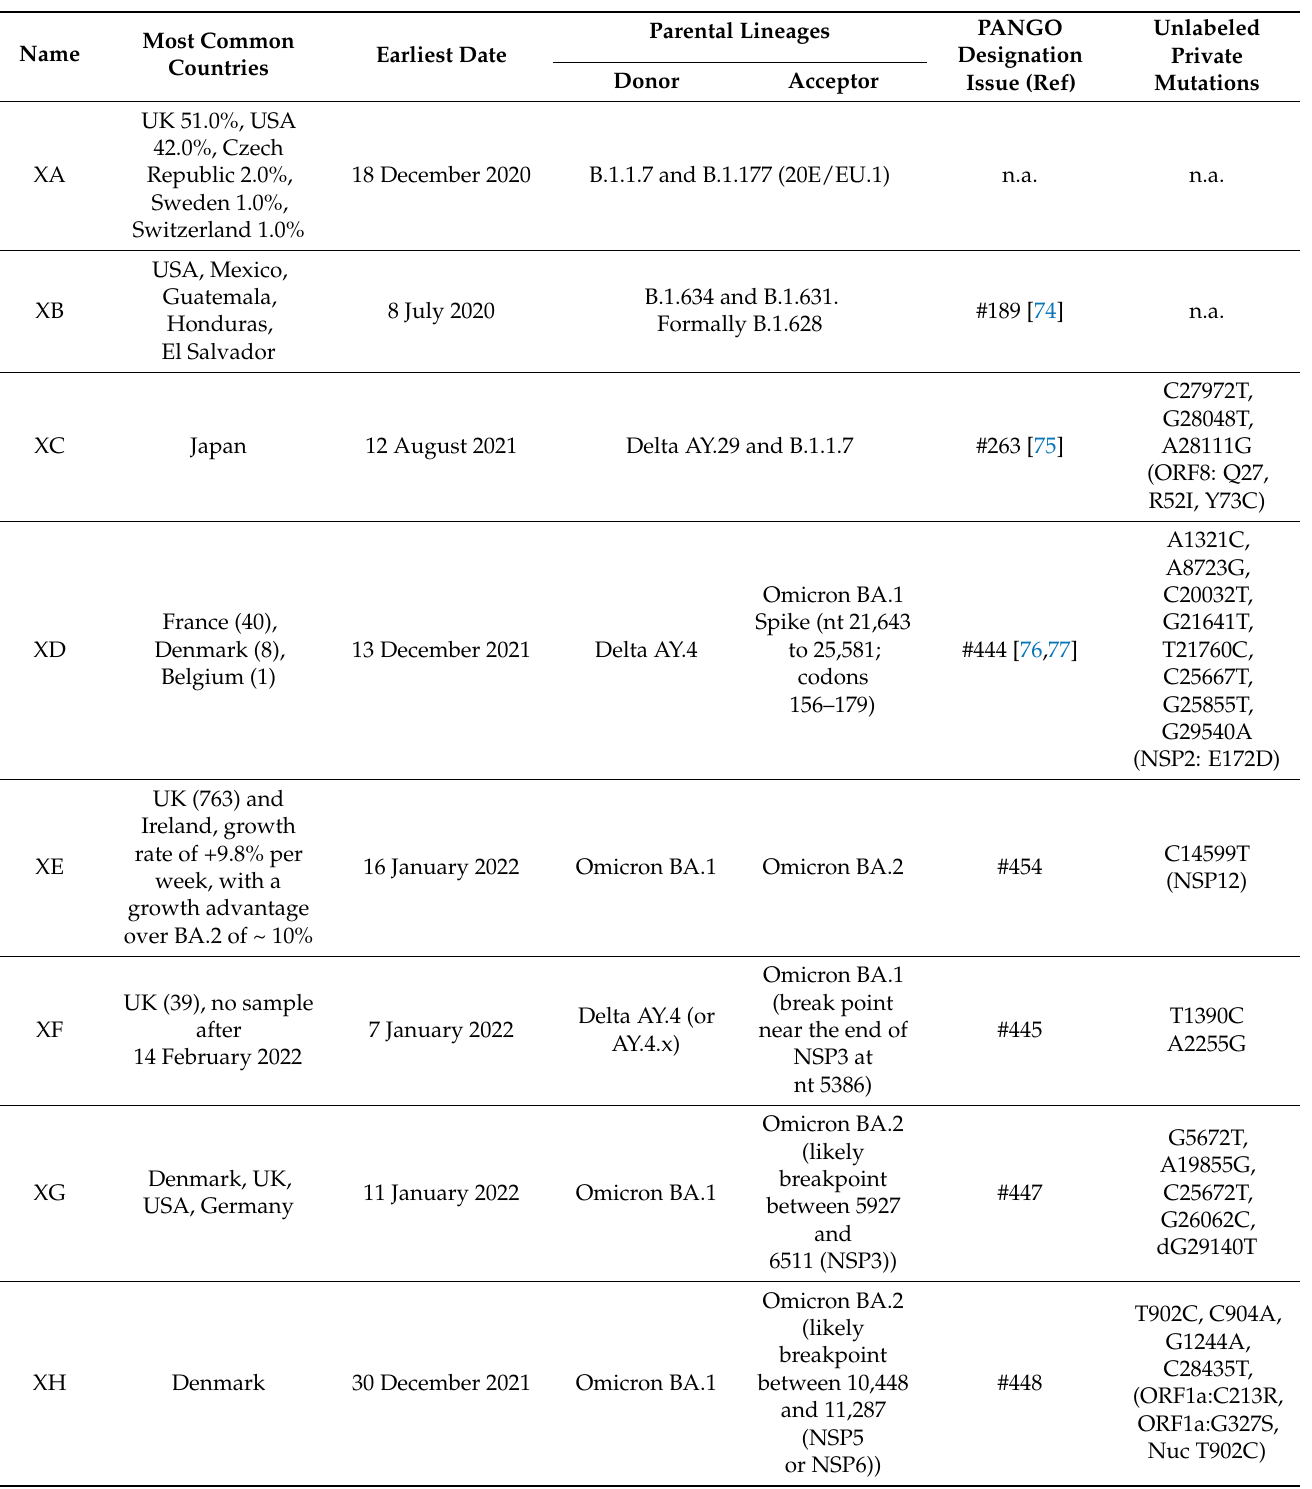
Table 1. Details of PANGO-assigned recombinant SARS-CoV-2 lineages (modified from